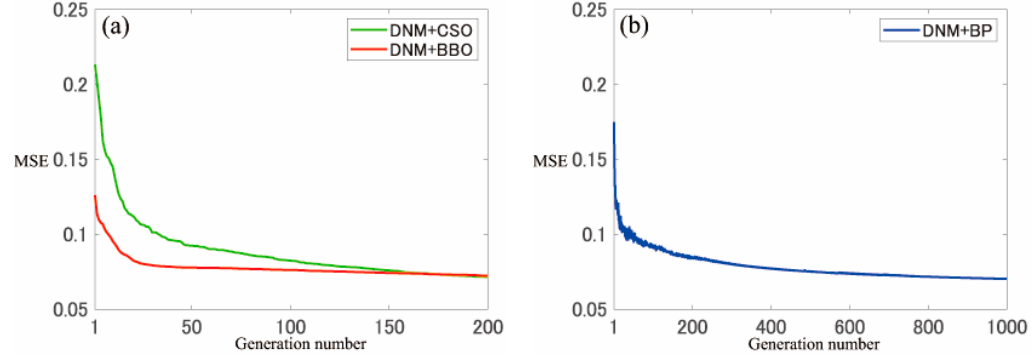
Figure 3. Convergence graphs of F1. ( a ) DNM + BBO and DNM + CSO, ( b ) DNM + BP.